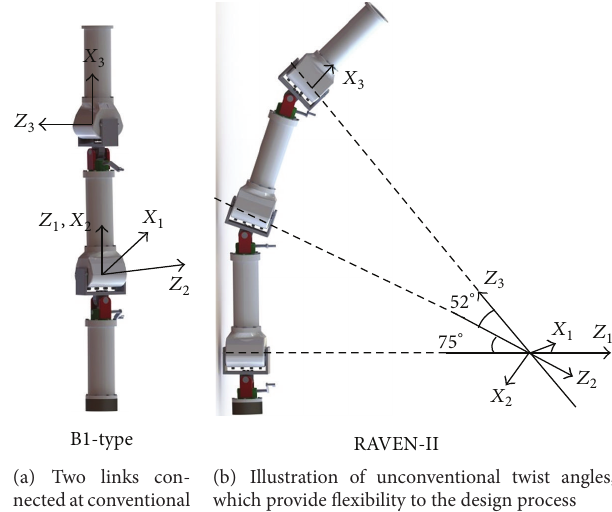
Figure 3: Unconventional robotic parameters.